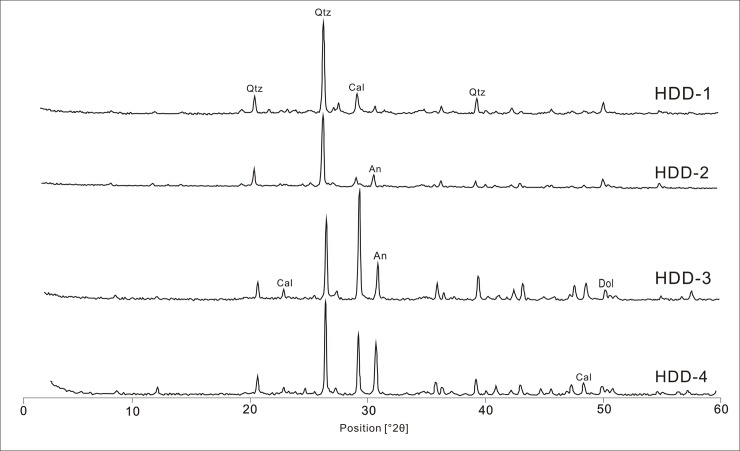
XRD patterns of rock samples from Hudiedong cave.Qtz = quartz, Cal = calcite, An = ankerite, and Dol = dolomite. Fig 6 is excluded from this article's CC-BY license. See the accompanying retraction notice for more information.